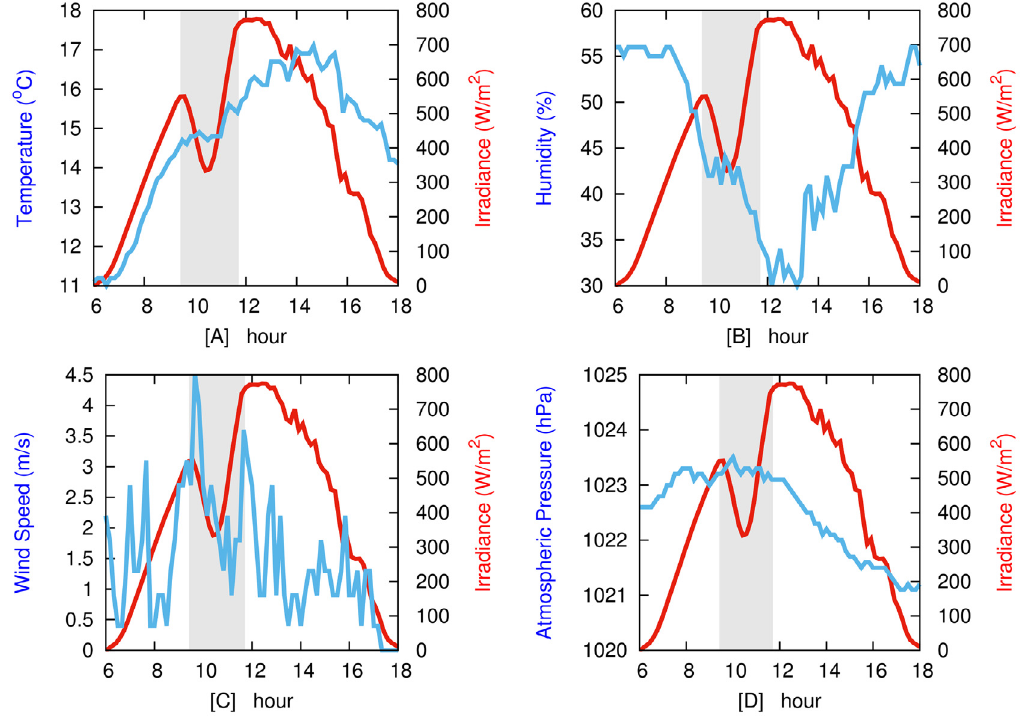
Figure 6. Meteorological variables versus solar irradiance values measured in Naples on March 20, 2015. The colored area highlights the pe- riod from 9:25 to 11:43 (UT+1, local time) when the eclipse occurred: see Table 1. (A) Temperature; (B) humidity; (C) wind speed; (D) at- mospheric